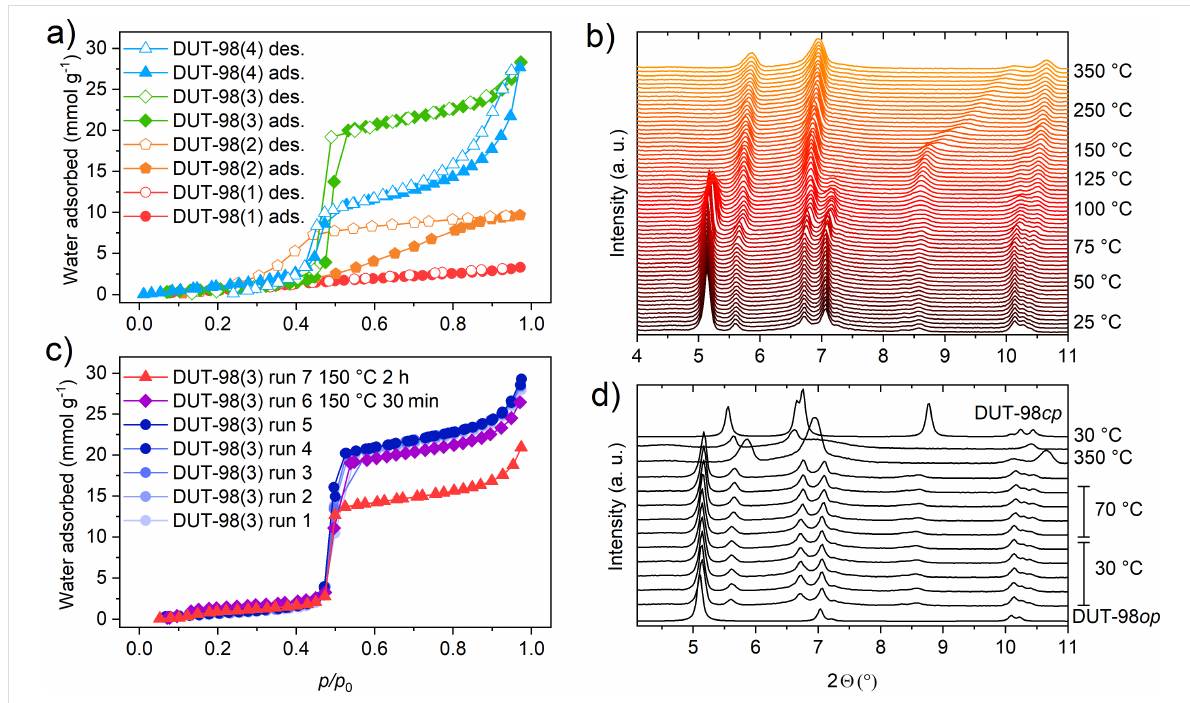
Figure 5: Water physisorption experiments at 298 K on: a) DUT-98(1)–(4) and c) DUT-98(3) after cycling and after thermal treatment. (Filled symbols: adsorption, open symbols: desorption). In situ temperature-variable PXRD of: b) DUT-98(2) and d) DUt-98(2) cycled at lower